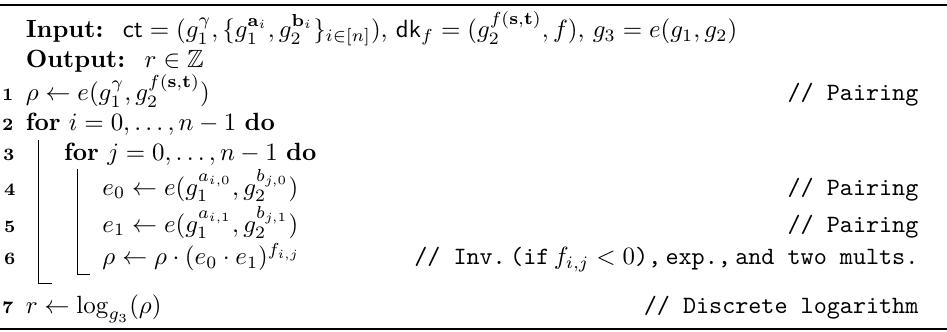
Algorithm 1: Decryption of the FE-QF scheme